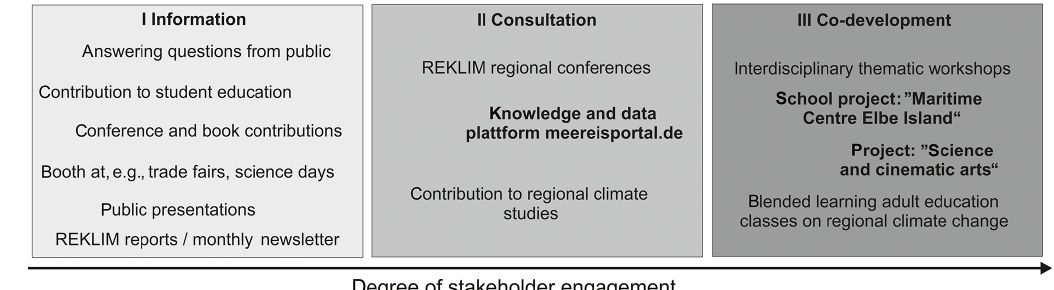
Figure 1. Idealized scheme for principle classification of working examples of REKLIM-HO and the Climate Office for Polar Regions and Sea Level Rise, according to the degree of stakeholder involvement in the specific activity as a distinctive feature. Highlighted (in bold) are the three case examples in the field of knowledge transfer and dialogue processes discussed in this